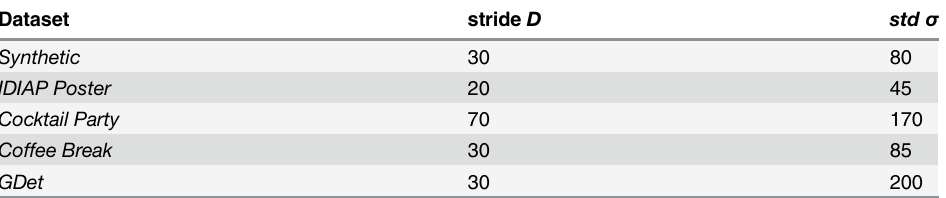
Table 4. Parameters used in the experiments for each dataset. These parameters are the results of a tun- ing phase and the difference are due to different measure units (pixels/cm) and different social environments (indoor/outdoor, formal/informal, etc.).